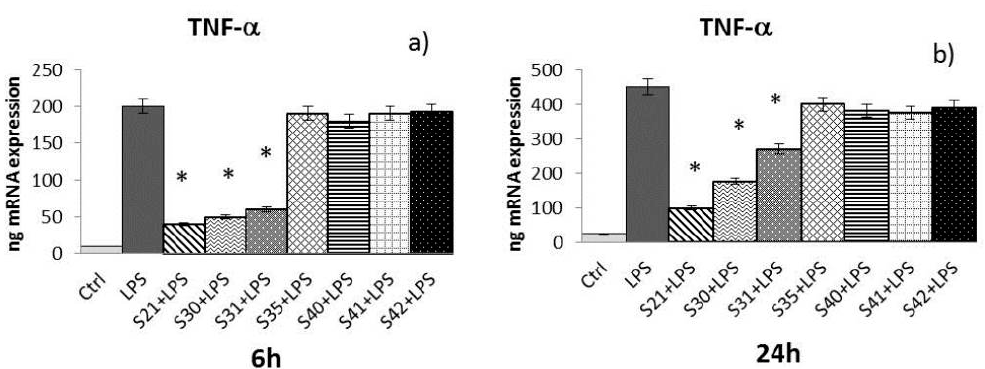
Figure 8. mRNA expression of TNF- α from HaCat cells treated with S21, S30 , S31, S35, S40, S41 and S42 non-woven tissue bio-composites (10 µ g/mL) plus P. aeruginosa lipopolysaccharide (LPS) (10 µ g/mL) 6 h ( a ) and 24 h ( b ). Data are mean ± SD of values calculated on two different experiments. * P < 0.05 compared to LPS (10 μ g/mL) alone.